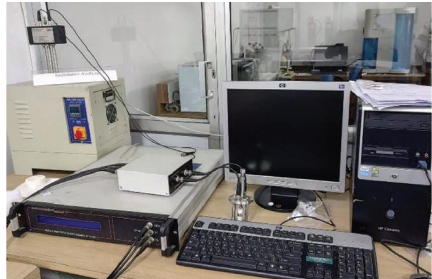
Figure 8: Impedance